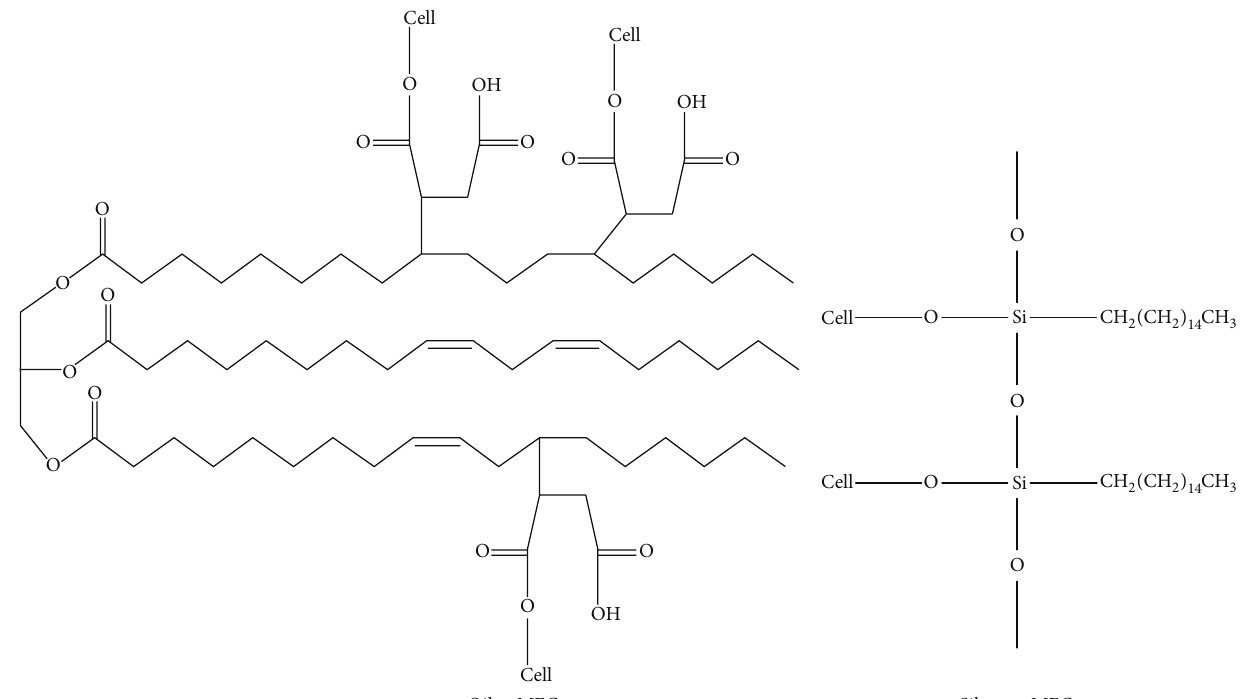
Scheme 1: Chemical structures of Oil-g-CF and